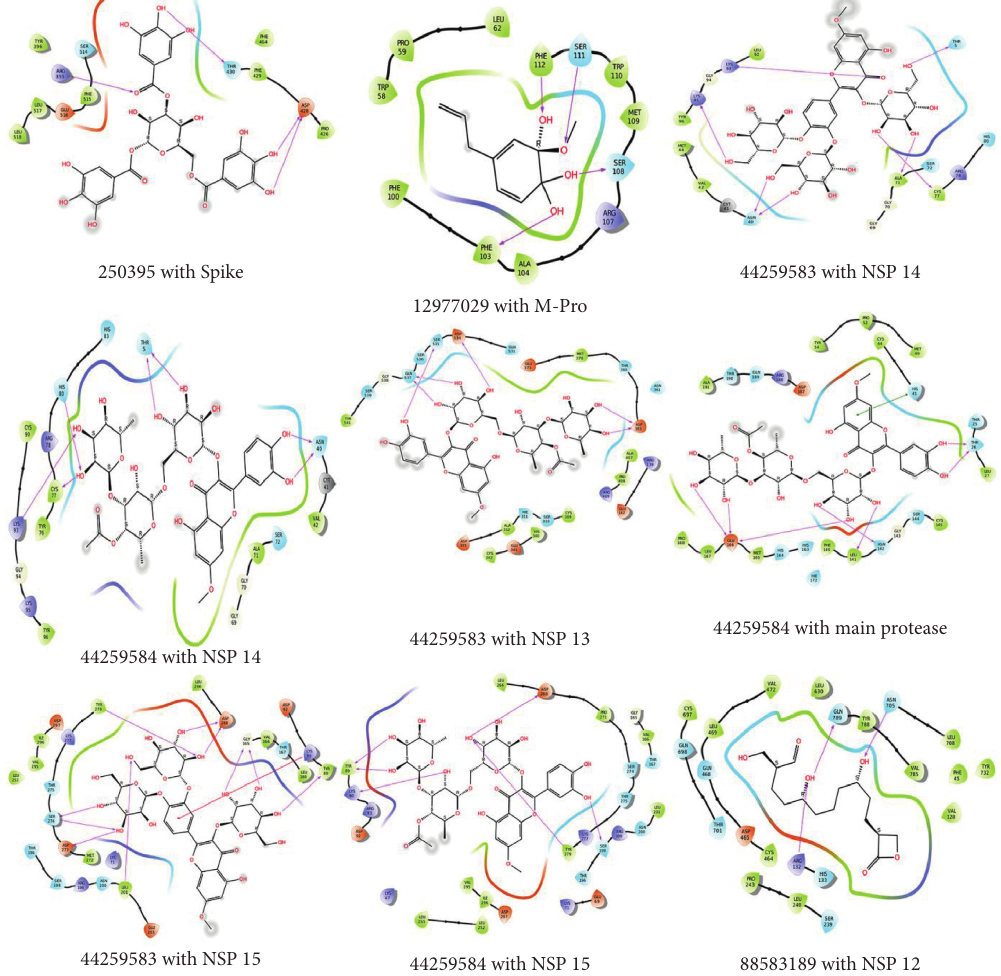
Figure 2: The 2-D interaction binding mode of Kabasura Kudineer compounds with SARS-CoV-2 proteins. The pink color arrow represents the hydrogen bond interactions, and the red color represents the Pi-cation